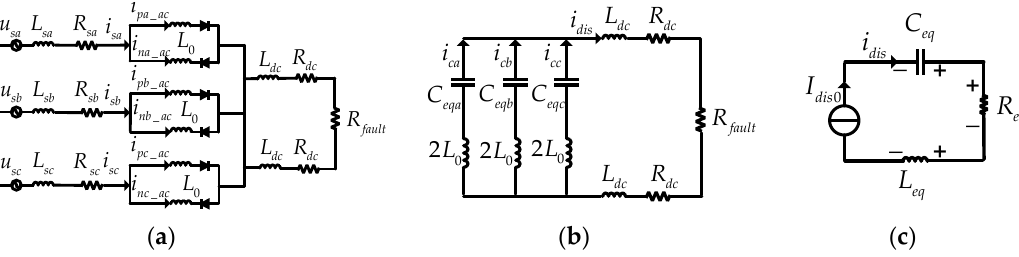
Figure 4. ( a ) Equivalent AC grid feeding current circuit, ( b ) equivalent SM capacitor discharging current circuit, ( c ) simplified SM capacitor discharging current circuit.